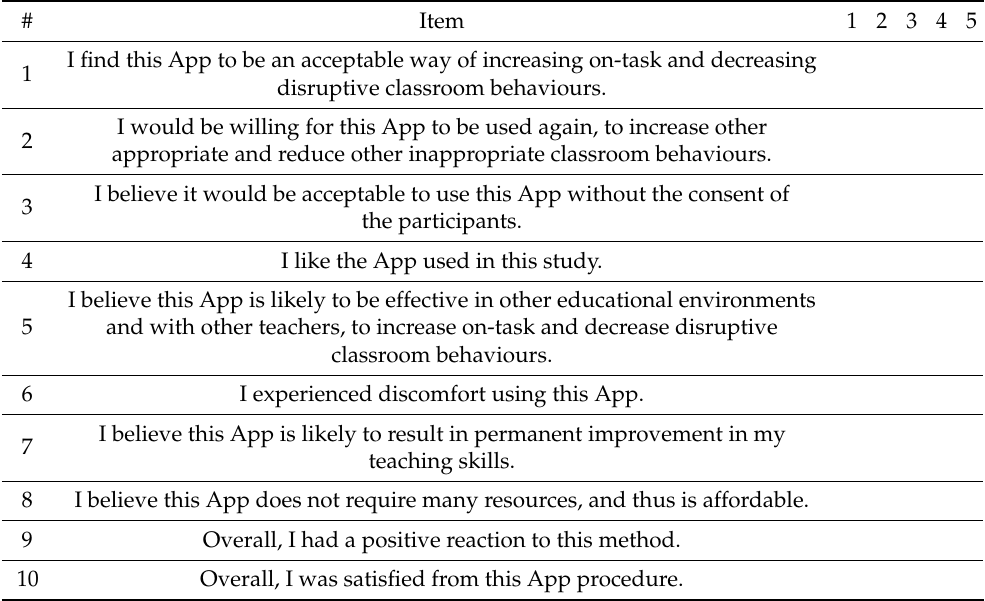
Table 2. Social validity